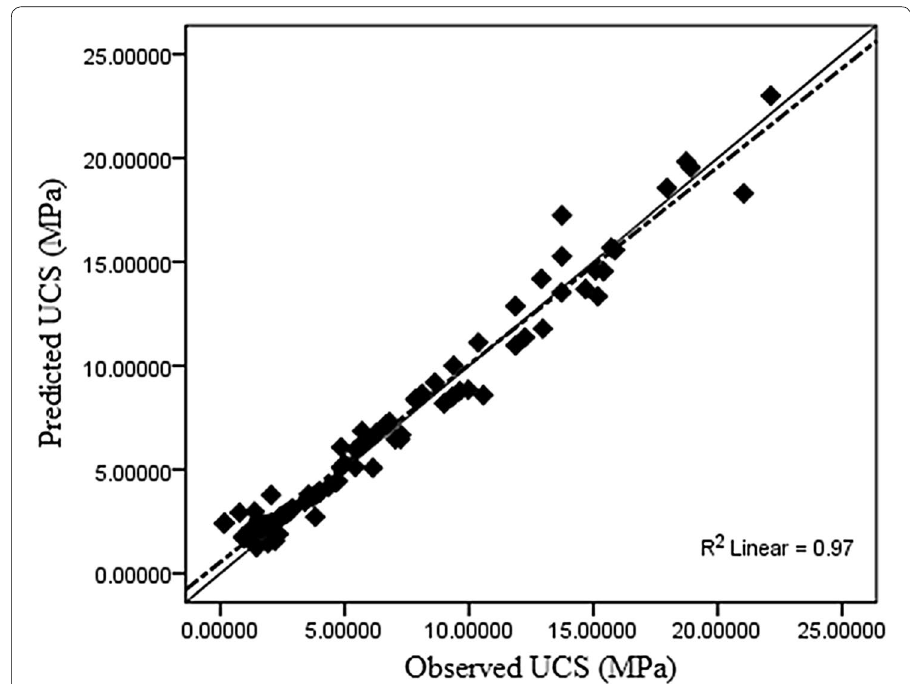
Fig. 3 Cross-correlation of predicted and observed values of UCS for regression model (Quadratic model)